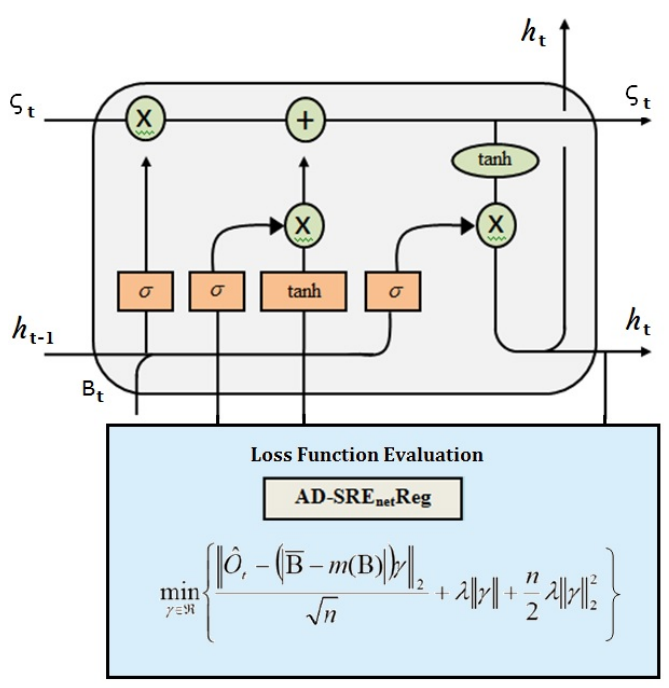
Figure 2. Proposed HT-RLSTM architecture.